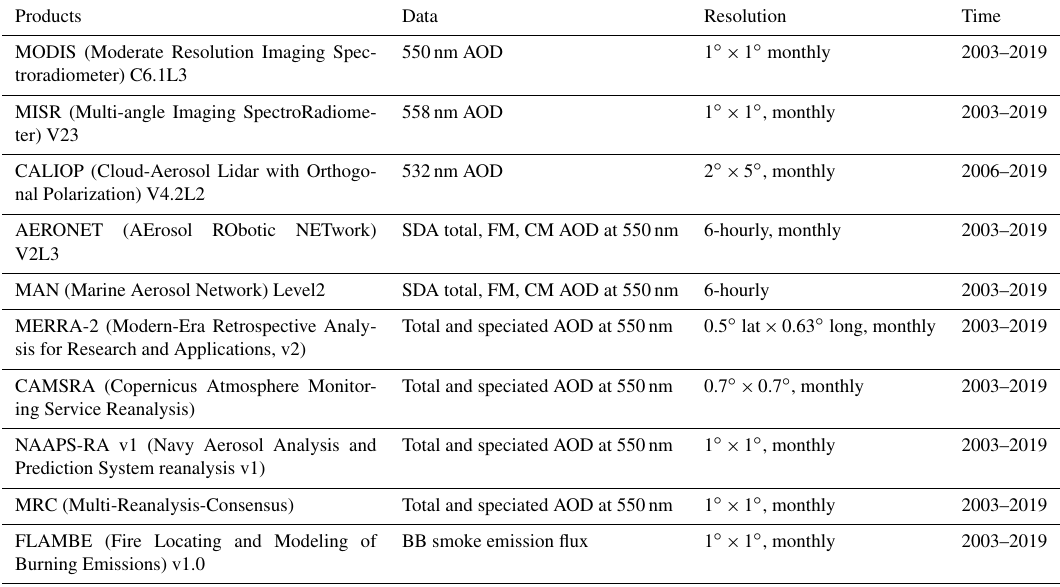
Table A1. Summary of data used in the study.